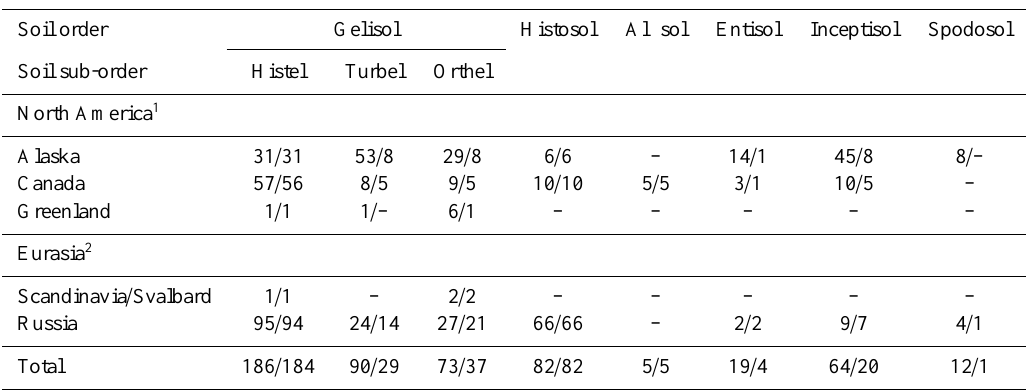
Table 1. Summary of number of available pedons with data in the 100–200cm (the first number) and 200–300cm (the second number) depth ranges for soil taxa from di ff erent regions (regional subdivision following NCSCD). The regions are grouped into the North American and Eurasian sections of the northern circumpolar permafrost